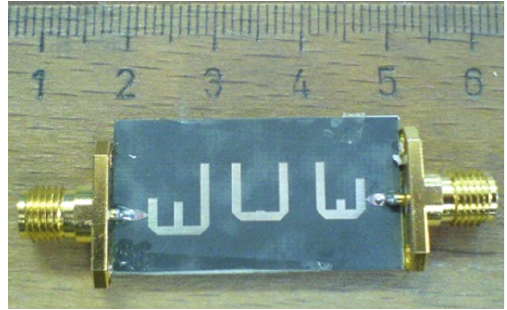
Figure 8: The photograph of the fabricated filter.